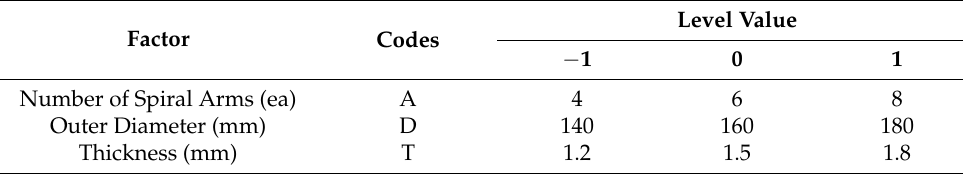
Figure 6. Geometric parameters of the spring for design. Table 1. Design Variables and Control Points.